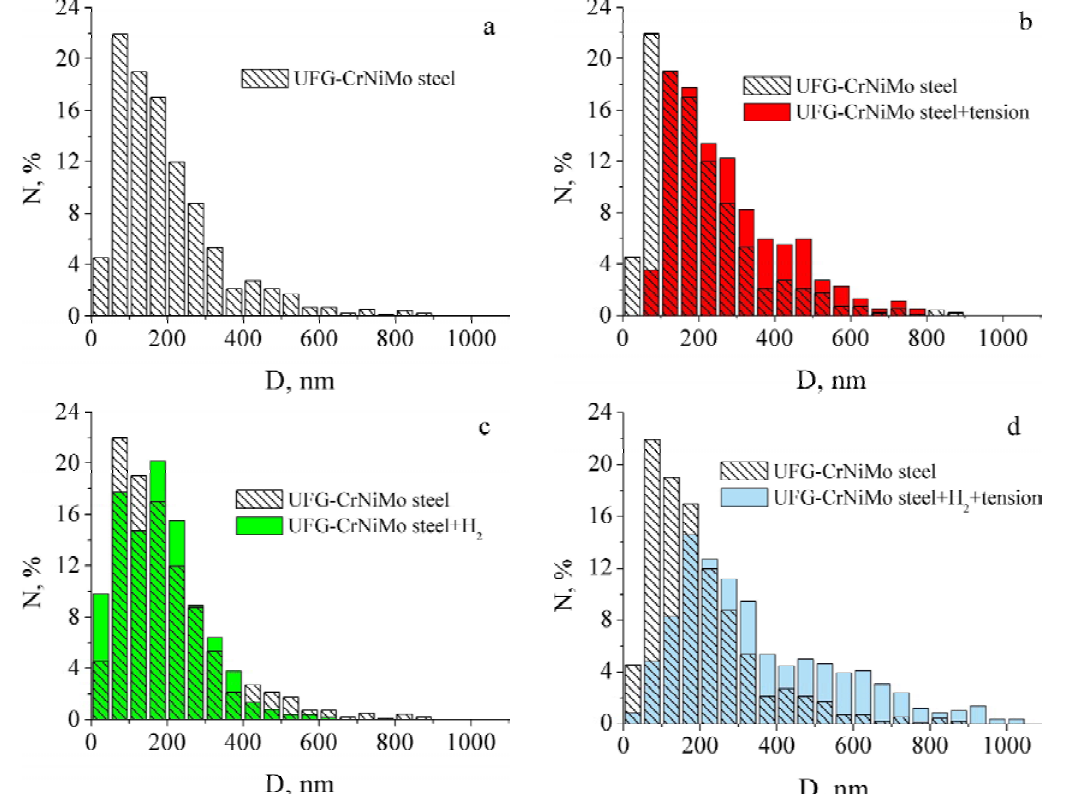
Fig. 5. Comparison of the (sub)grain size distributions in UFG-CrNiMo steel after different treatment re- gimes: a – initial state (as-ABC-pressed); b – combined diagrams for initial state and initial state + tension; c – combined diagrams for initial state and initial state + hydrogen charging for 100 hours; d – combined diagrams for initial state and initial state + hydrogen charging for 100 hours + tension to fracture.